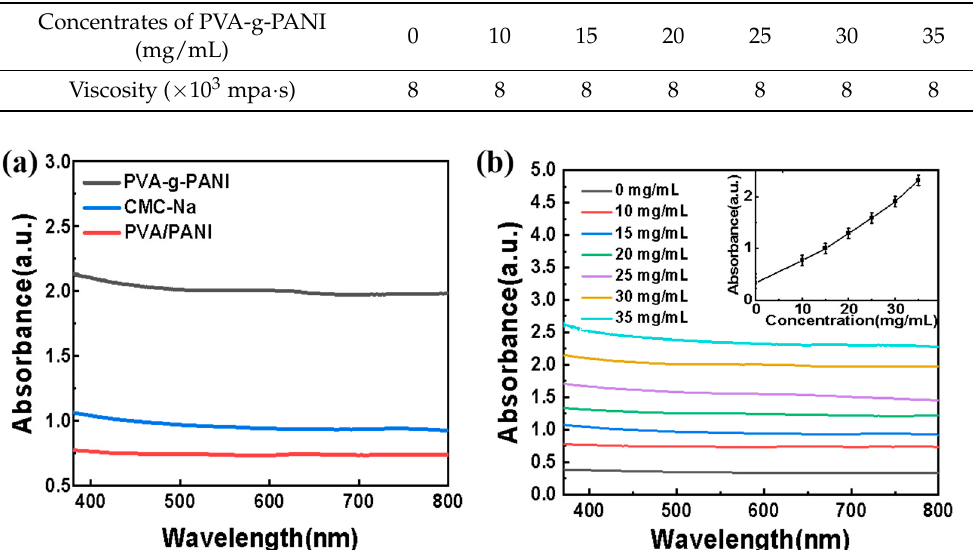
Figure 3. UV–Vis absorption spectra of graphene dispersion prepared with ( a ) different surfactants and ( b ) varying concentrates of PVA-g-PANI.